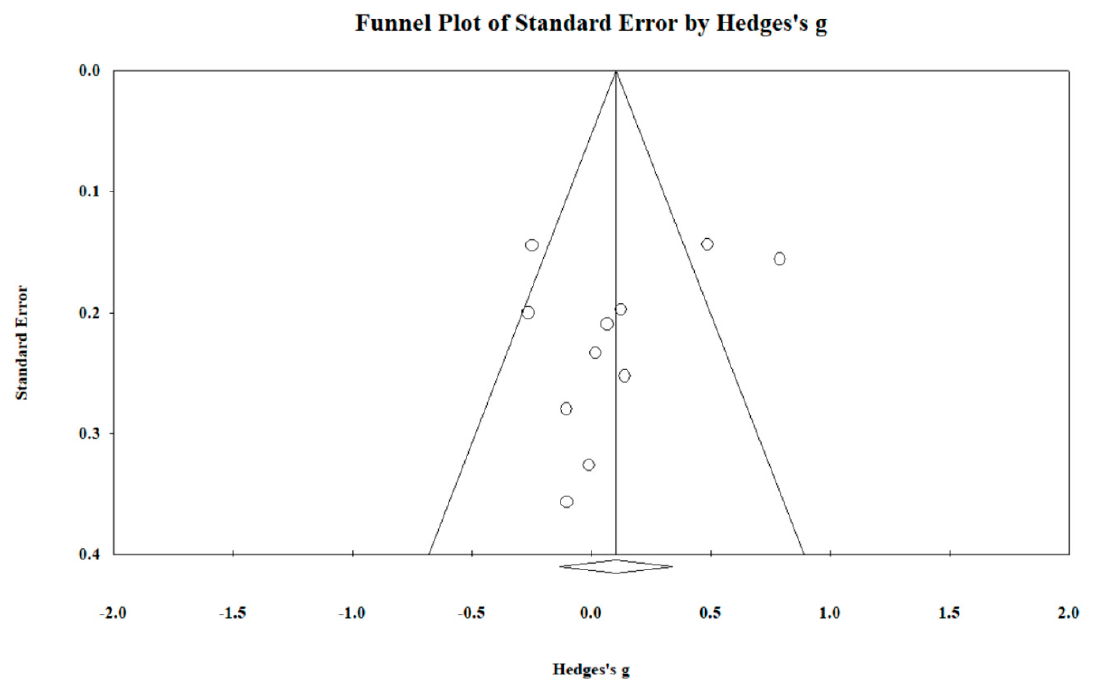
Figure A2. Funnel plot of Hedges’ g vs. standard error for congruent stimuli.